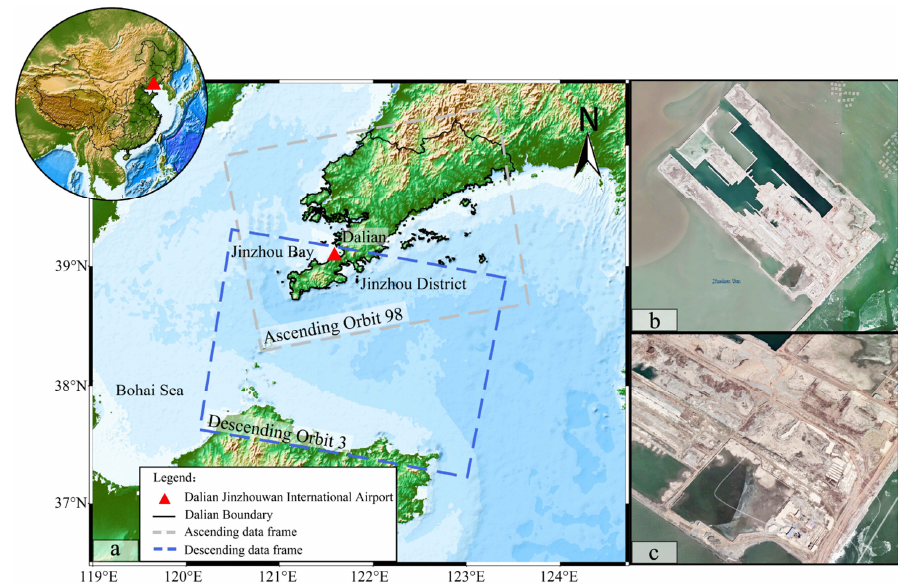
Figure 1. Overview of Dalian Jinzhou Bay International Airport: ( a ) Location of the study area; ( b , c ) Satellite map of the study area. Remote Sens. 2021 , 13 , x FOR PEER REVIEW